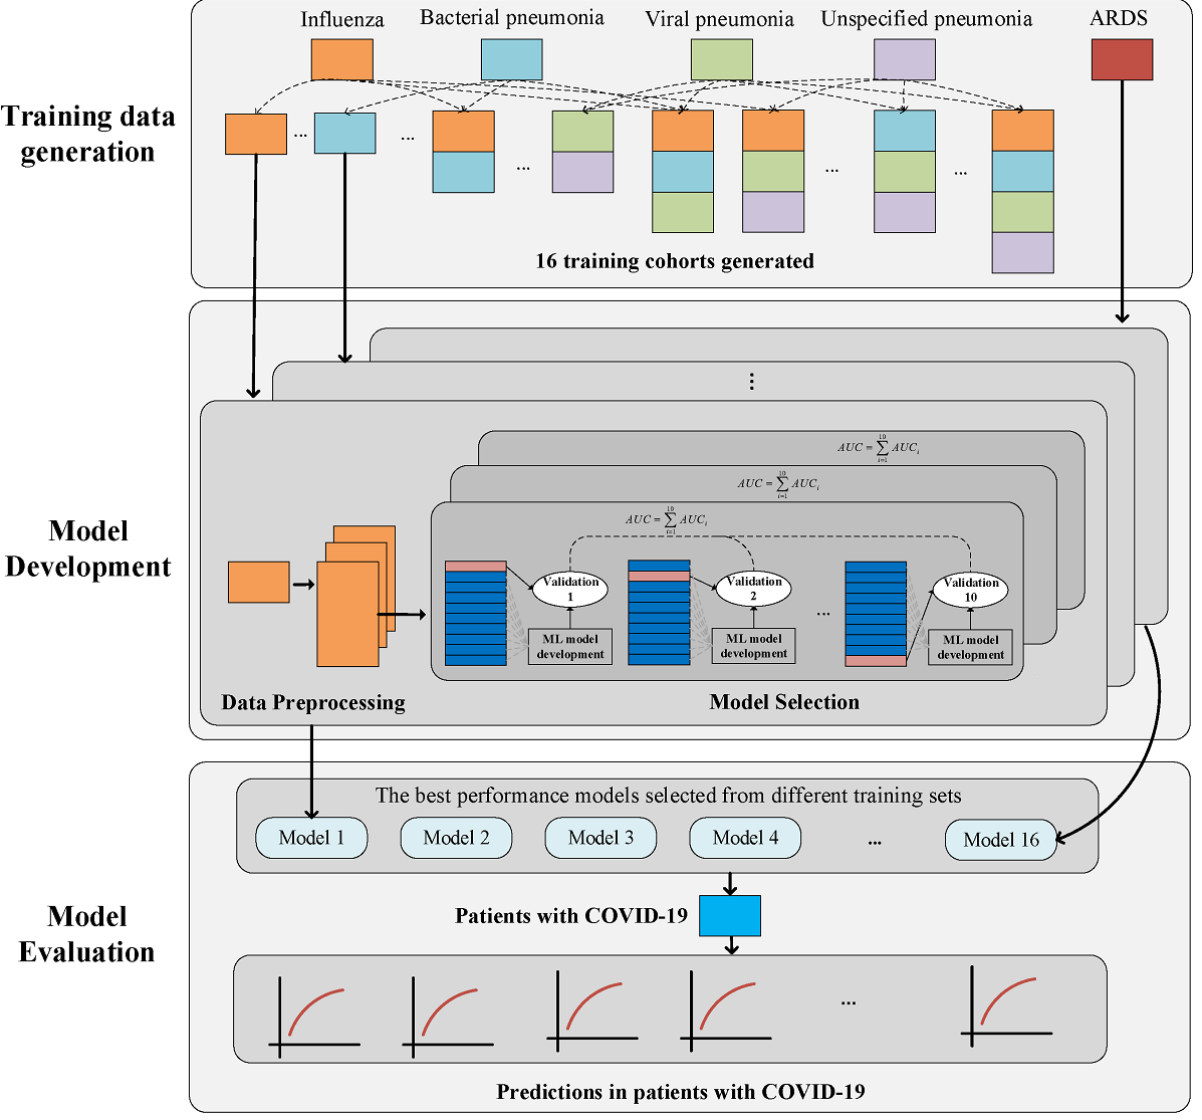
Figure 1. The methodological framework for selecting training data cohort, model development, and model evaluation for predicting intubation and